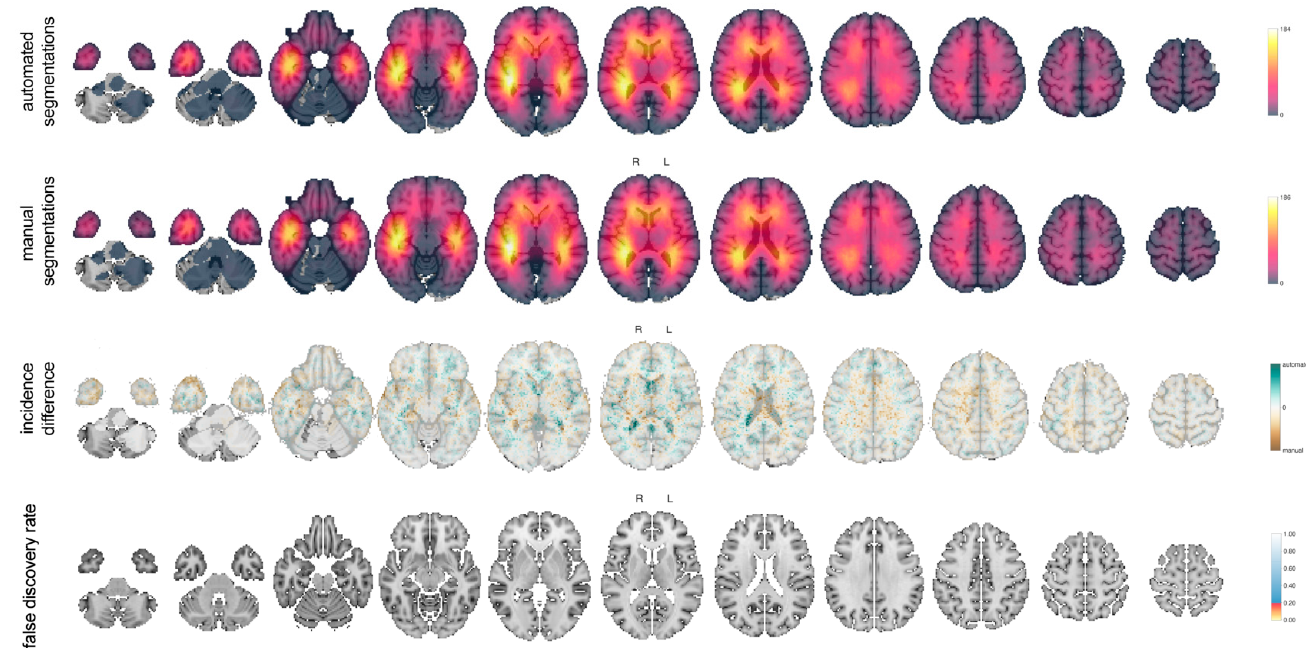
Figure 7. Tumor probability maps for the automated and manual segmentations. Each voxel represents the tumor incidence in the study population with false discovery rates of the difference between the incidences, as specified in the